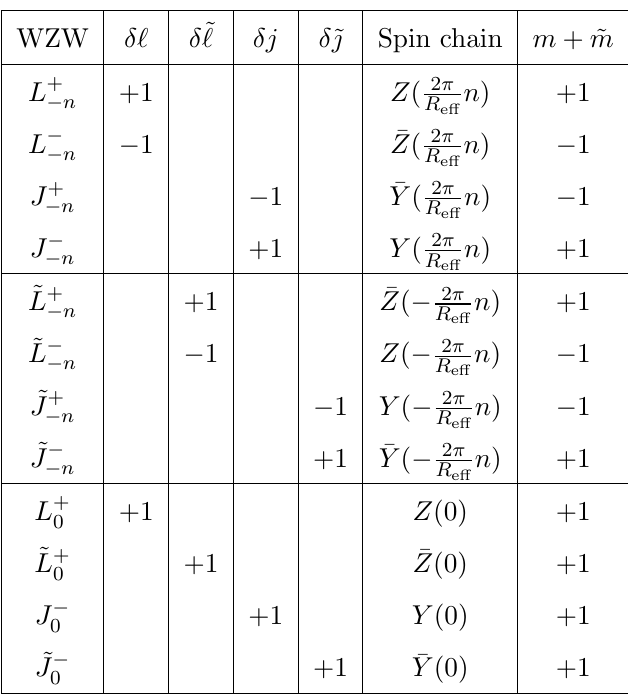
Table 3 . We match the bosonic excitations in the un(cid:13)owed sector of the WZW model to the spin chain, along with the respective mode numbers (or momenta). In the (cid:12)rst box, we list the chiral excitations with n (cid:21) 1; in the second one, the anti-chiral excitations with ~ n (cid:21) 1. The zero- modes are listed separately, and discussed below. Notice that while in the chiral sector we have e.g. J (cid:0) (cid:24) Y , in the anti-chiral one we have ~ J + (cid:24) (cid:22) Y , see also (cid:12)gure 2. Identi(cid:12)cation of the mode